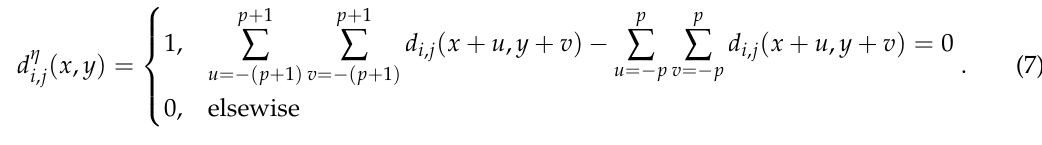
( x , y ) and ˜ g a ( x , y ) ; and ( d ) defect i , j i , j